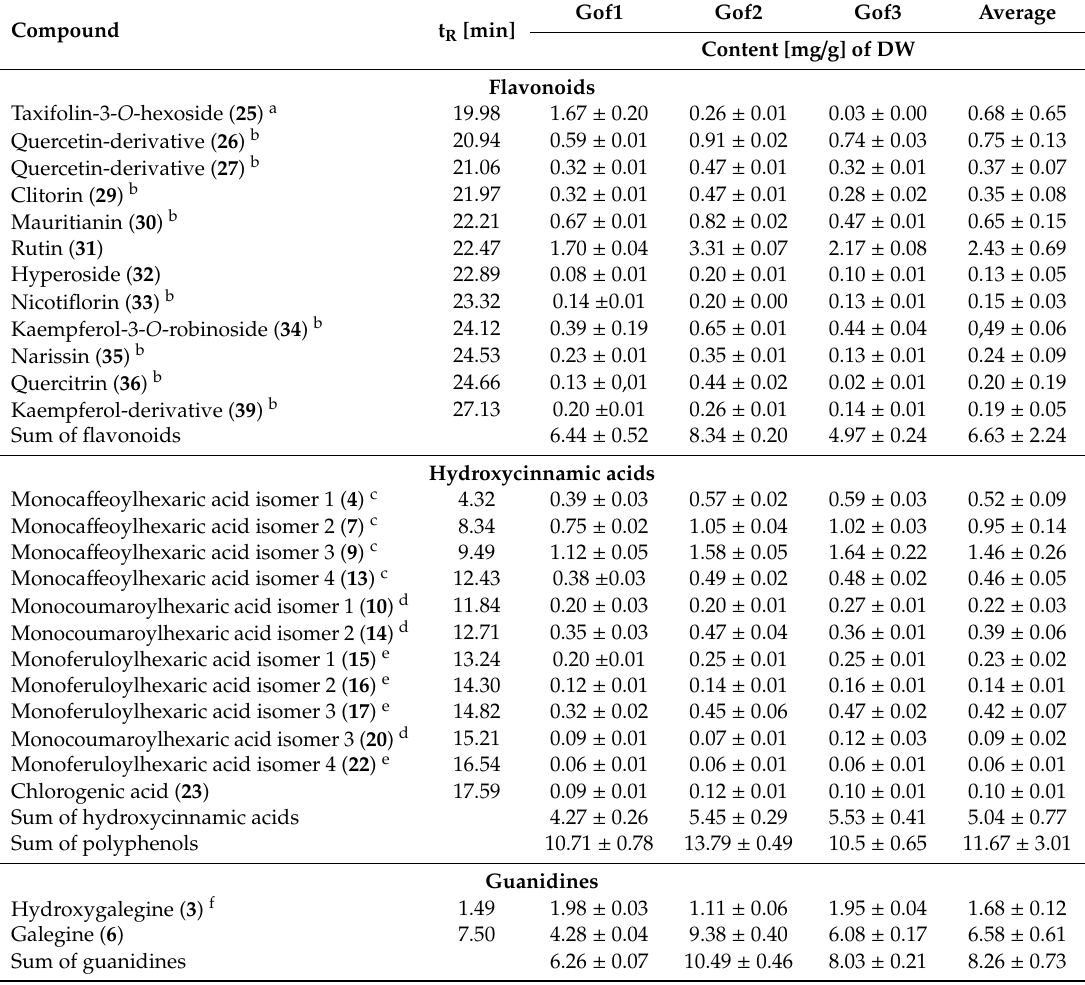
Table 2. Quantification of polyphenolics and guanidines in water infusions (drug extract ratio, 1:50) from three di ff erent batches of G. o ffi cinalis (Gof1-Gof3), expressed as mg per 1 g of dried plant